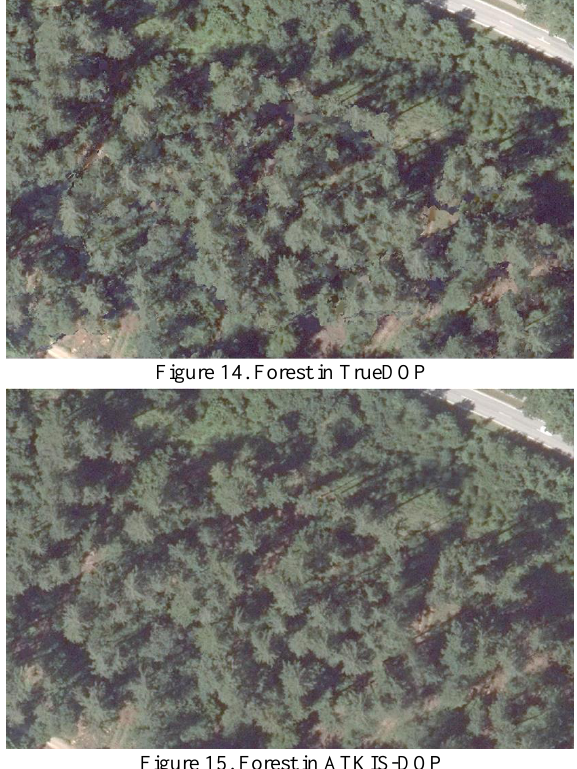
Figure 15. Forest in